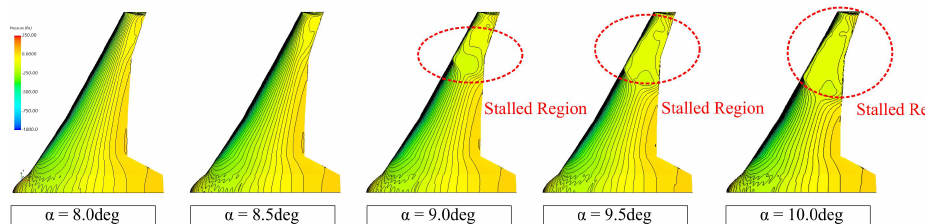
Figure 9. Development of stall pattern.